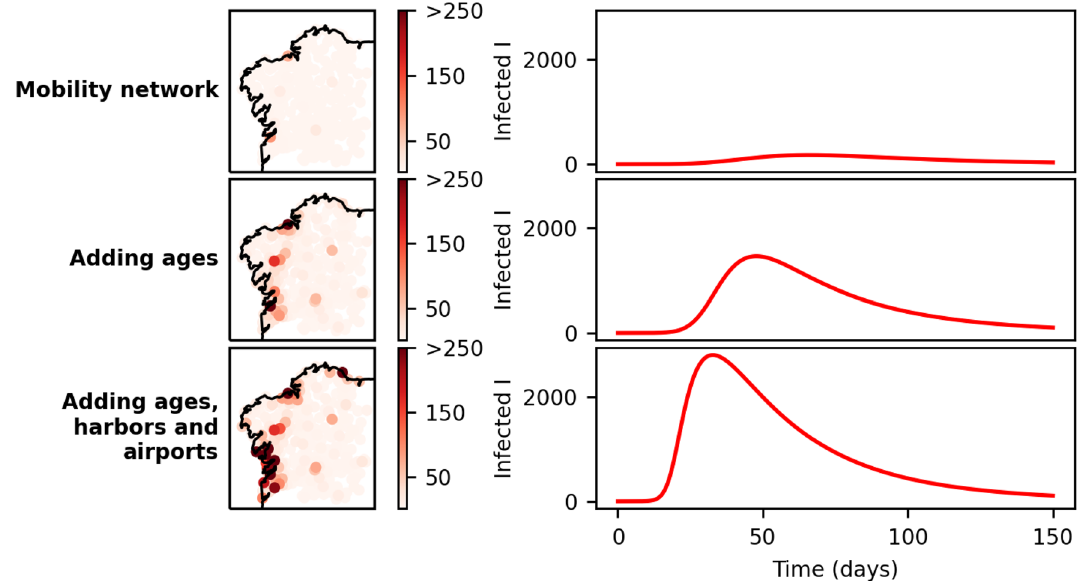
Figure 8. Different levels of complexity on the network model. The left panels show the normalized values of the infection peak for each one of the nodes, distributed spatially. The right panels show the time evolution of the infected individuals for one specific node, Burela, situated on the northeastern coast. To start the simulation, an initial infected seed was placed into each